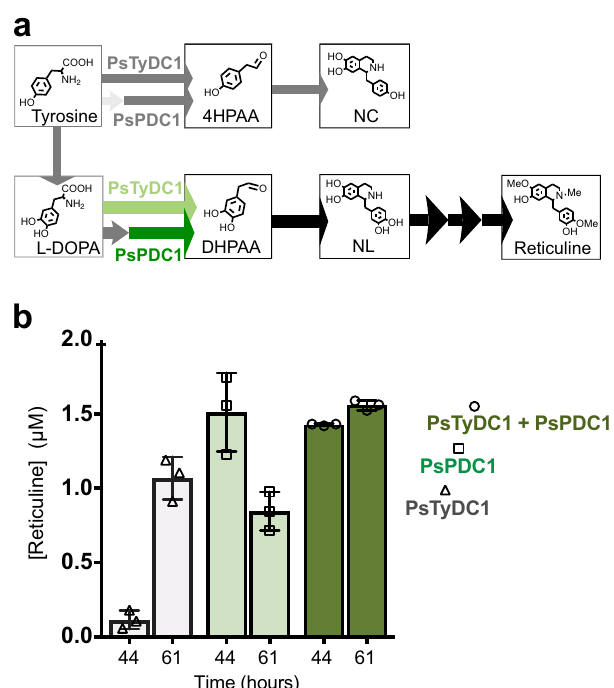
Fig. 6 PsPDC1 and PsTyDC1 promote the norlaudanosoline pathway from L-DOPA to reticuline. a Pathway expansion of the P. somniferum 4HPAA pathway to a dual norcoclaurine (NC) and norlaudanosoline (NL) pathway. b Strains T1-10-DE3, P1-02-AI and P1-04-AI contain PpDDC, PsONCS3, Cj6OMT, CjCNMT, and Cj4OMT in addition to PsTyDC1 (grey), PsPDC1 (light green) and PsTyDC1 + PsPDC1 (dark green), respectively. Cultures were grown to high density in TB before addition of inducing agent, L-DOPA and ascorbate according to the methods section. 61 h after addition of L-DOPA substrate, PsPDC1-mediated reticuline titers declined, likely due to oxidative degradation. Replicate samples of fi ltered culture medium were analyzed with CE-MS ( n = 3). Here, 3 samples from individual cultures ( n = 3) were analyzed to generate bar graphs in Prism 7 with error bars representing mean values + / − standard deviations. Source data are provided as a Source Data fi